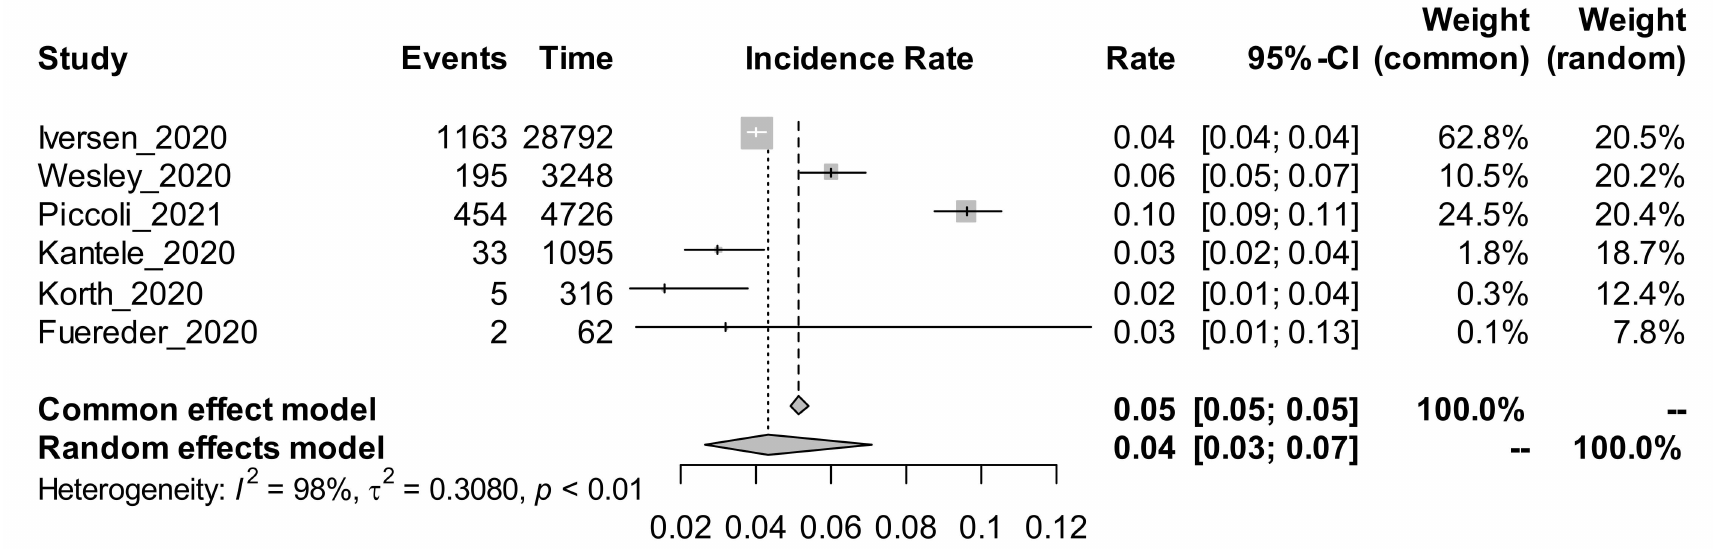
Figure 3. Forest plot showing the incidence rate of COVID-19 among studies using the antibody method of